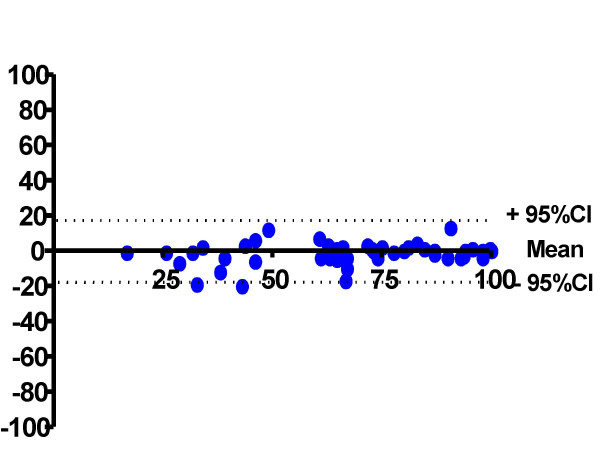
Bland-Altman plot of the Swedish VISA-P score in the reliability (test-retest within 1 week) investigation. Each blue dot indicates the difference in the total score, in relation to the mean score, between the two assessments.